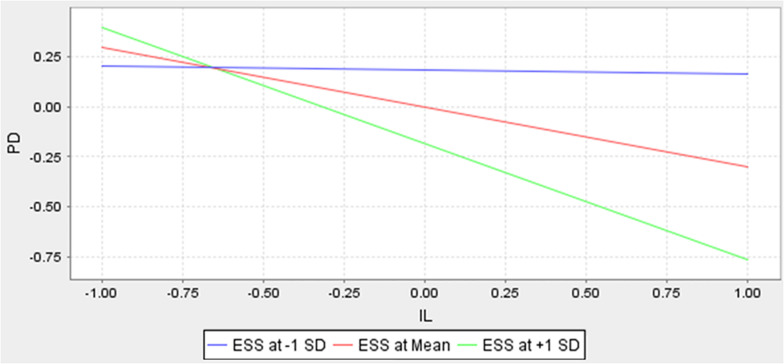
Moderation Effect.